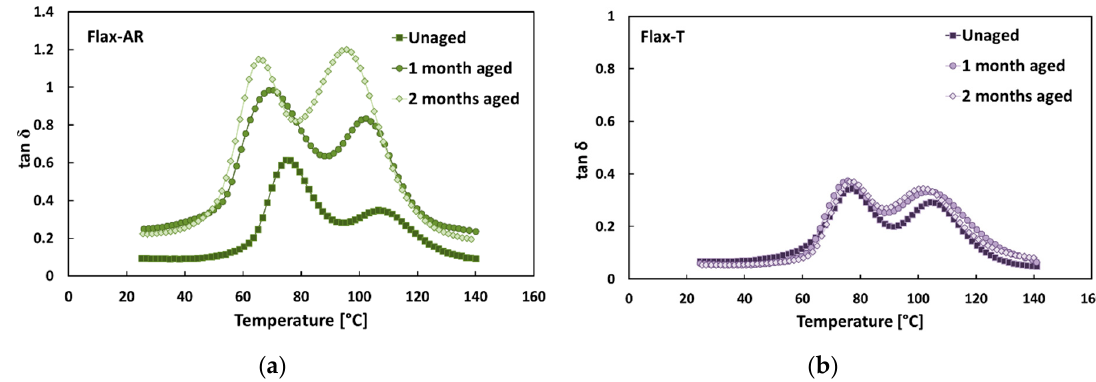
Figure 2. Typical tan δ trends of flax composites in each aging condition: ( a ) Flax ‐ AR composites; ( b ) Flax ‐ T composites.